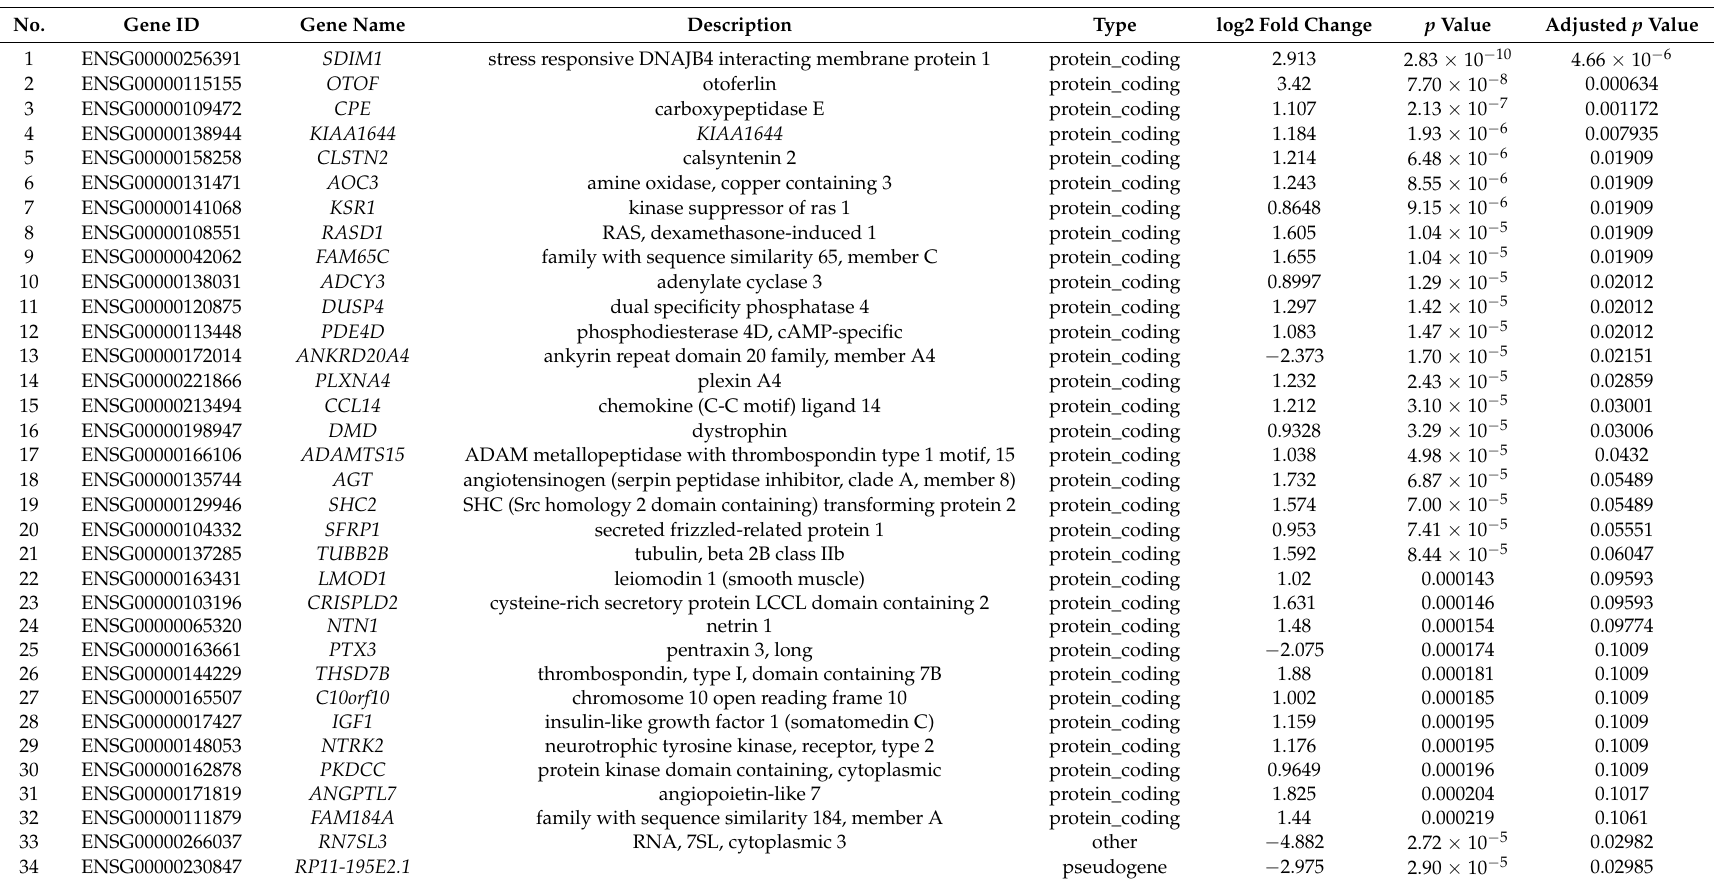
Table 2. List of genes and long noncoding RNAs differentially expressed in synovial tissue of patients with contrast pain